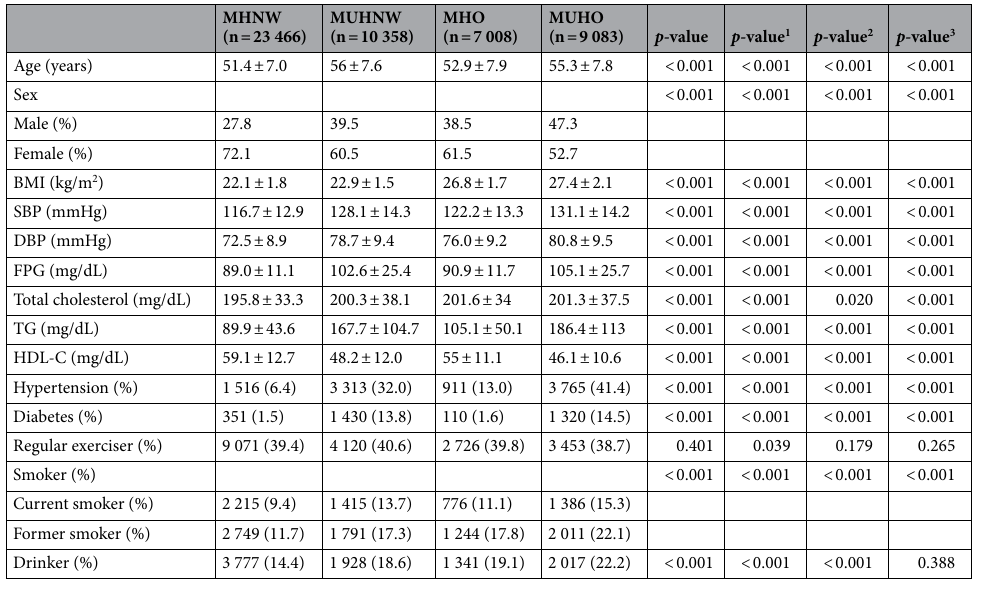
Table 1. Clinical characteristics of the study participants categorised into the four obesity phenotypes. Data are presented as the mean ± standard deviation or percentage. We obtained p -values by one-way analysis of variance or independent two-sample t -tests for continuous variables or by χ 2 tests for categorical variables. p -values represent the difference in each variable among the MHNW, MUHNW, MHO and MUHO phenotypes. MHNW, metabolically healthy normal weight; MUHNW, metabolically unhealthy normal weight; MHO, metabolically healthy obese; MUHO, metabolically unhealthy obese; BMI, body mass index; SBP, systolic blood pressure; DBP, diastolic blood pressure; FPG, fasting plasma glucose; TG, triglyceride; HDL-C, high-density lipoprotein cholesterol. p -values 1 represent the difference in each variable between the MHNW and MUHNW phenotypes. p -values 2 represent the difference in each variable between the MHO and MUHO phenotypes. p -values 3 represent the difference in each variable between the MUHNW and MHO